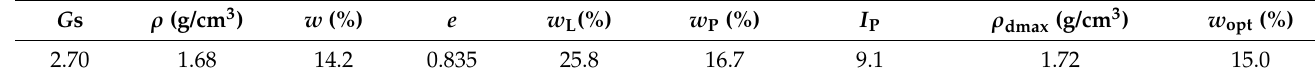
Table 1. Main physical properties of loess.